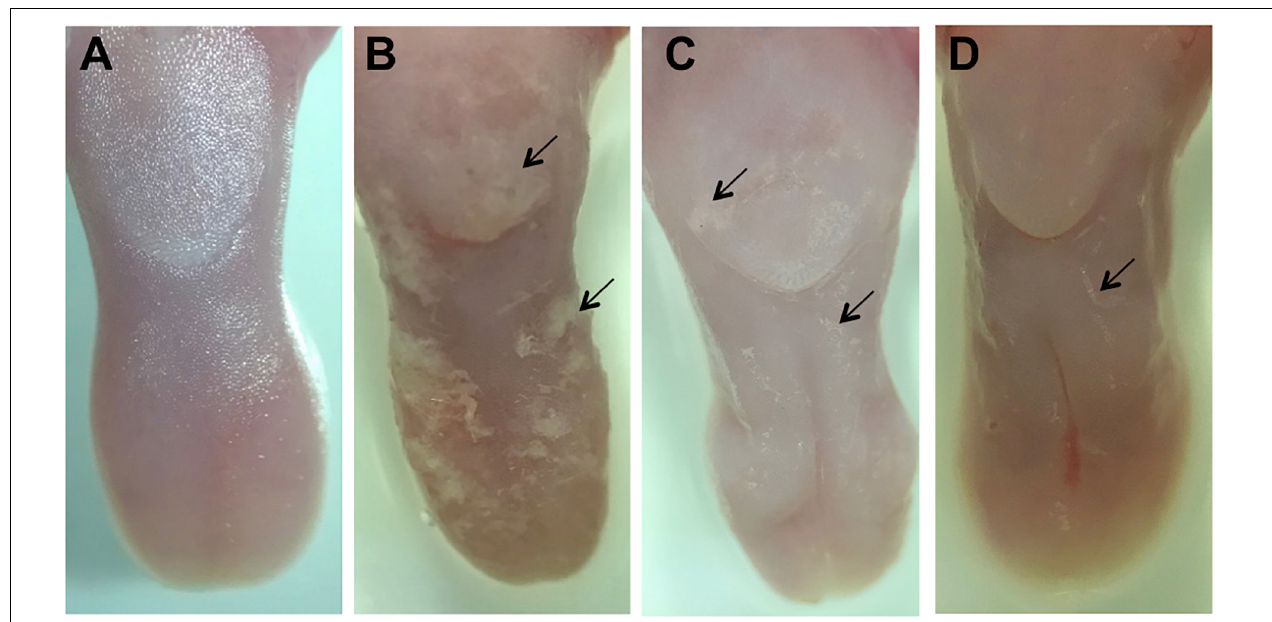
FIGURE 7 | Macroscopic images of the dorsum tongue. Control group not infected by C. albicans : normal aspect of tongue (A) . Control group infected by C. albicans and not treated: presence of numerous white patches of candidiasis lesions ( → ) and papillary atrophy (B) . Groups treated with SM-F1 (C) or SM-F2 (D) showing few areas of white patches ( → ) and papillary